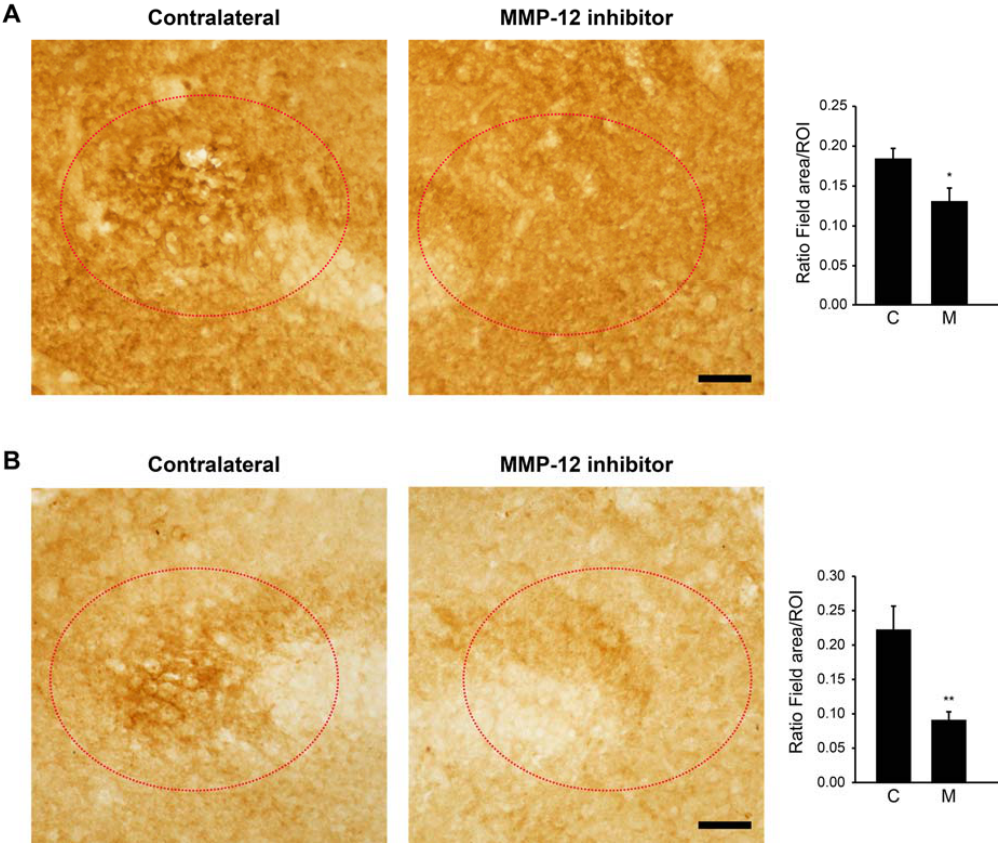
Figure 4. Effect of MMP ‐ 12 inhibition on IgG and albumin extravasation in the CA3 stratum lacunosum ‐ moleculare of rats after pilocarpine ‐ induced SE. Brain sections were stained against local IgG ( A ) and albumin ( B ). The specific MMP ‐ 12 inhibitor significantly decreased edema as revealed by IgG and albumin extravasation. Quantification of the field area inside the region of interest (red ‐ dotted circle) was performed using the image analysis software KS300. C = contralateral hemisphere, M = MMP ‐ 12 inhibitor. Data are shown as mean ± SEM. n = 7. * p < 0.05, ** p < 0.01; Student’s t ‐ test. Scale bars: 50 μ m. bars: 50 µ